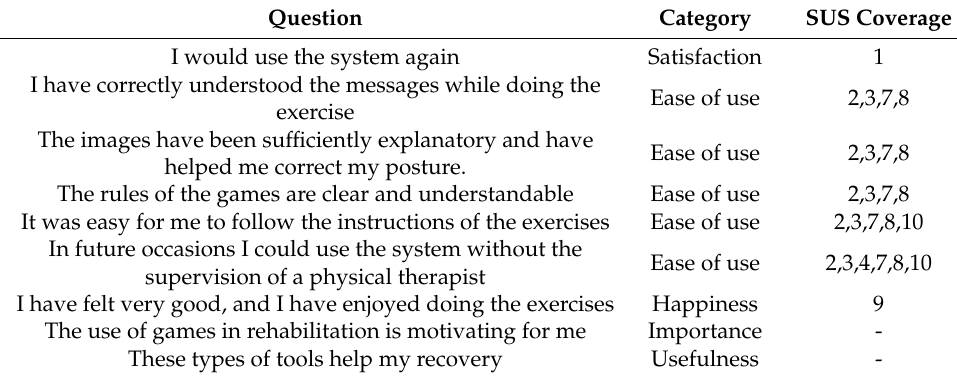
Table 3. Questionnaire designed for the acceptability study. Each question is classified into usability categories and related with SUS